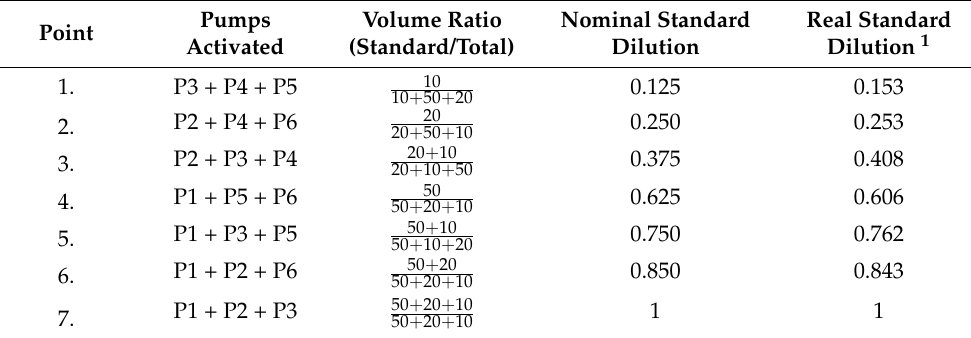
Table 4. Procedure of standard dilution during the calibration